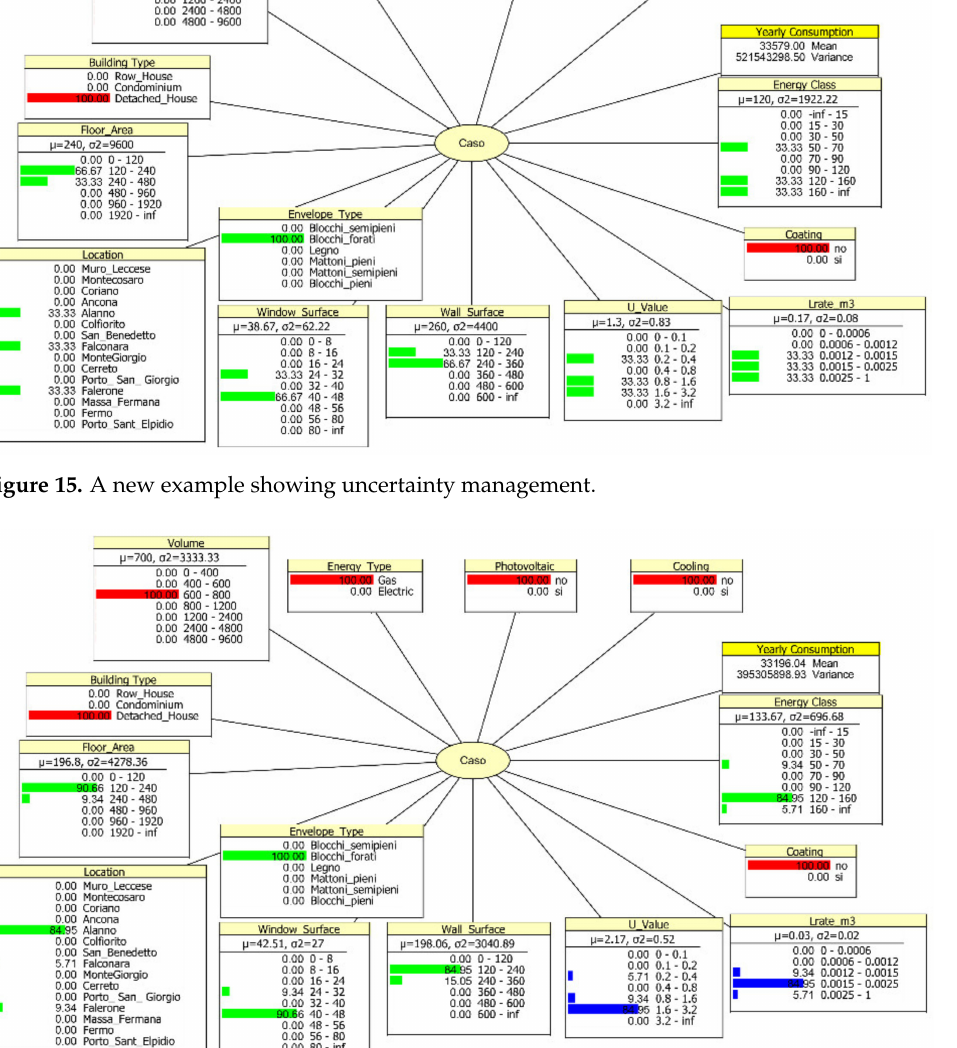
Figure 16. The result after observing the ‘Infiltration’ variable distribution.